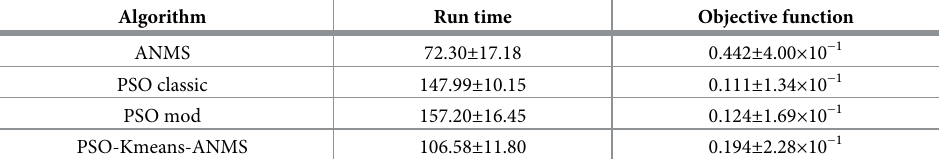
Table 10. Case 1 (100 × 20). Results of the mean value and the respective standard deviation for the CPU time and the objective